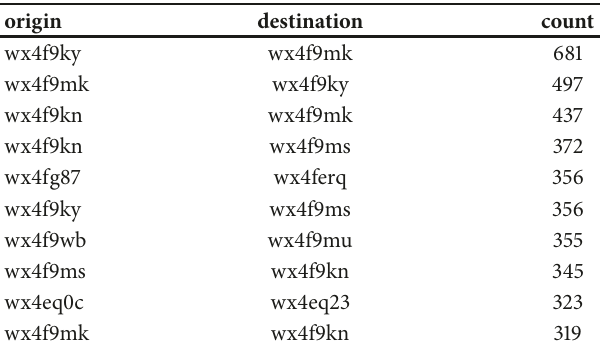
Table 4: The top 10 origin and destination